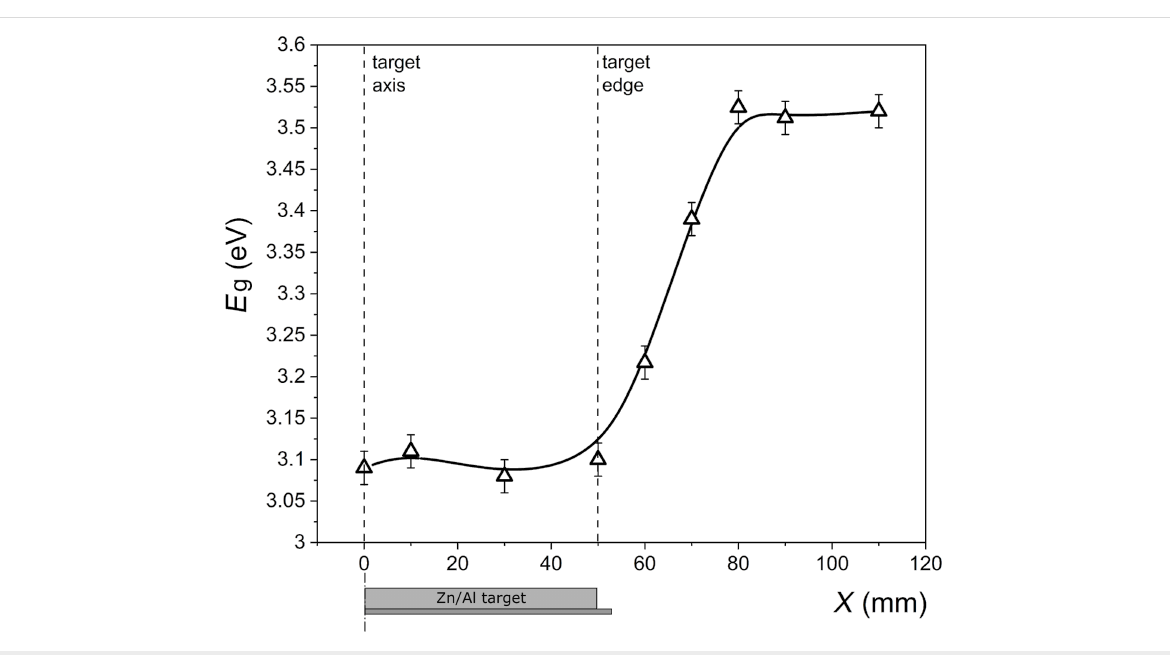
within a distance of up to 30 mm from the target axis, had a mixture of ZnO crystallites of the size of 4.0–4.4 nm and Al 2 ZnO 4 crystallites of the size of 4.8–5.2 nm. With increasing distance from the target axis, the crystallite size of both